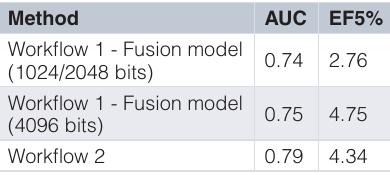
Table 3. Evaluation results for anti- malaria activity on the held-out test set (1056 molecules). Predictions were obtained using the fusion models of Workflow 1 and the linear combination of model scores of Workflow 2. The maximum possible EF5% value is 10.5.